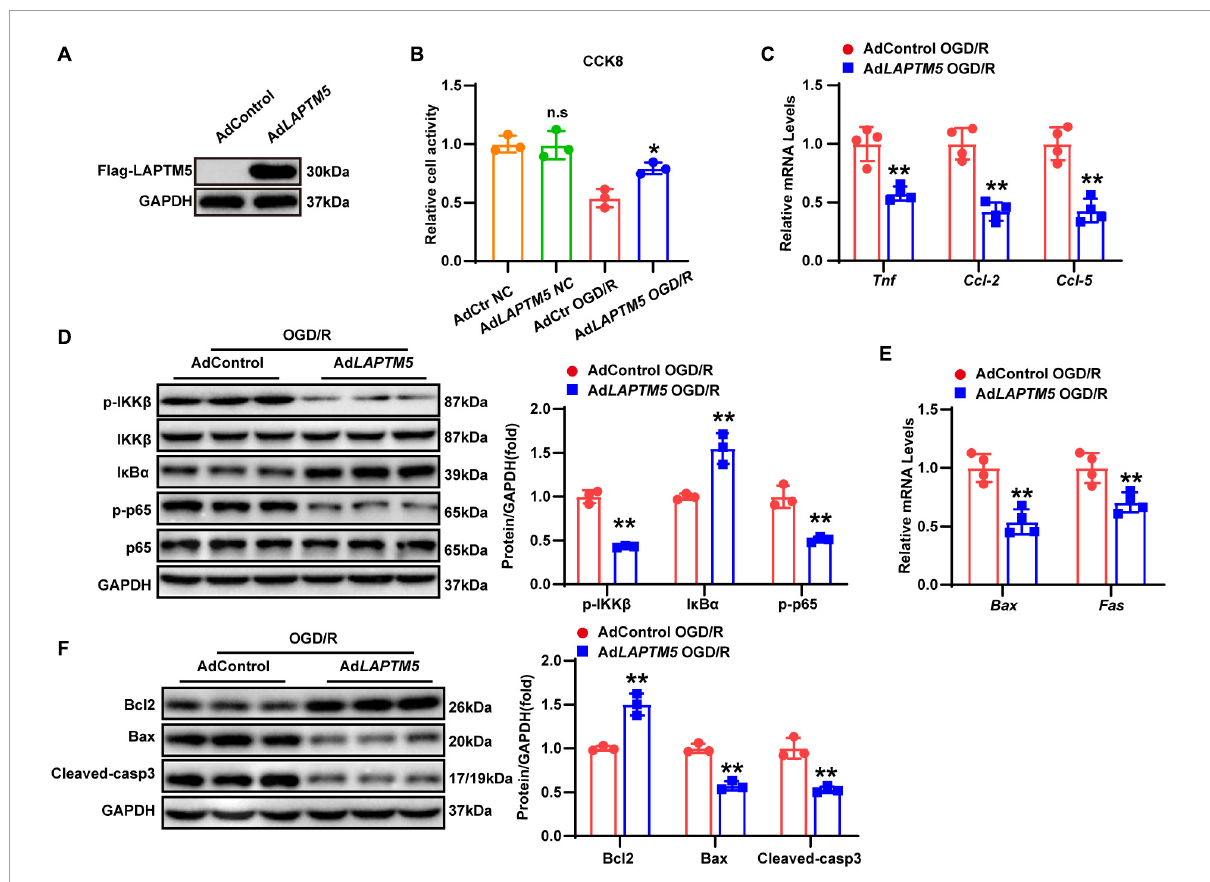
FIGURE6 LAPTM5 overexpression attenuates neuronal inflammation and apoptosis in primary neurons following OGD/R. (A) Western blot of LAPTM5 expression in the control and LAPTM5 overexpressing primary neurons. (B) The LAPTM5 overexpressing group showed higher cell viability after OGD/R, while it did not affect viability of neurons cultured under normal conditions, n = 3 independent experiments, * p < 0.05 vs. the AdControl OGD/R group, n.s. indicates no significance vs. the AdControl NC group. (C) LAPTM5 overexpression decreased the mRNA levels of proinflammatory genes ( Tnf, Ccl-2, and Ccl-5 ) after OGD/R, n = 4 independent experiments, ** p < 0.01 vs. the AdControl OGD/R group. (D) Western blot analysis revealed that the protein levels of phosphorylated IKK β and p65 were decreased, while that of I κ B α was upregulated in the Ad LAPTM5 group after OGD/R, n = 3 independent experiments, ** p < 0.01 vs. the AdControl OGD/R group. (E) Primary neurons in the Ad LAPTM5 group showed decreased pro-apoptotic gene ( Bax, Fas ) expression after OGD/R, n = 4 independent experiments, ** p < 0.01 vs. the AdControl OGD/R group. (F) Western blot reflected higher expression of anti-apoptotic proteins (Bcl2), while pro-apoptotic proteins (Bax and Cleaved-caspase 3) were decreased in the Ad LAPTM5 group after OGD/R, n = 3 independent experiments, ** p < 0.01 vs. the AdControl OGD/R